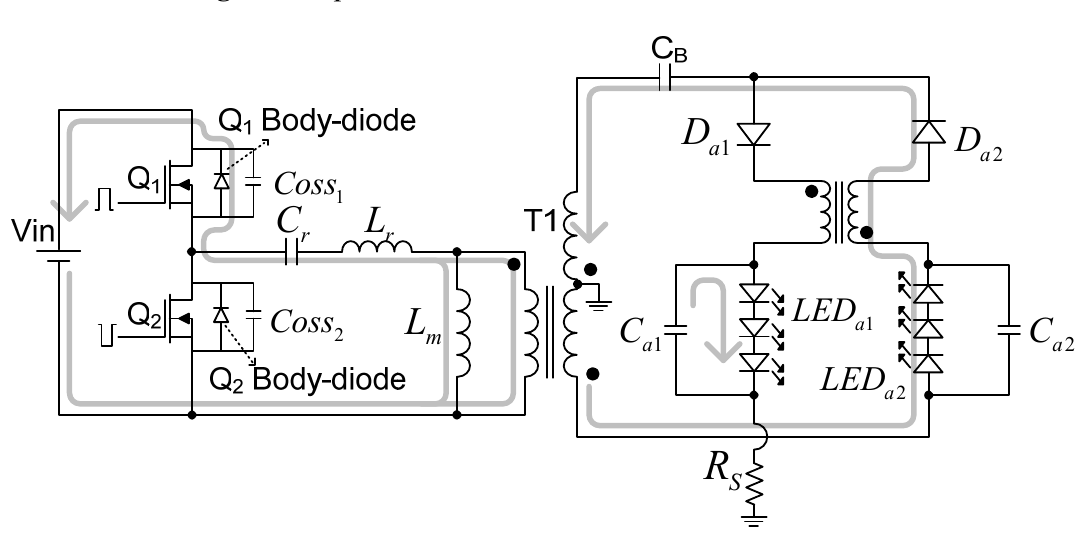
Figure 5. Operation waveform of LLC resonant converter.